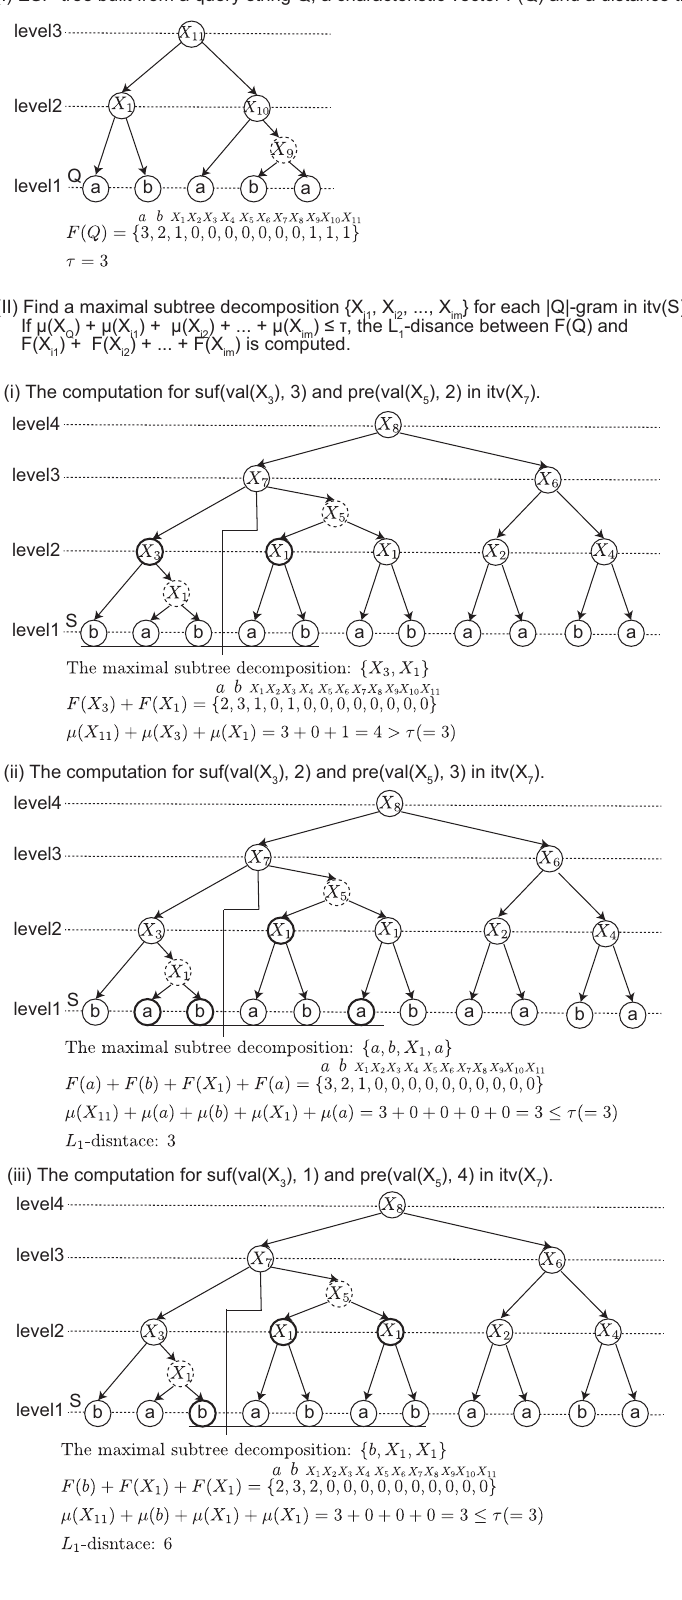
Figure 4. Illustration of candidate finding and L 1 -distance